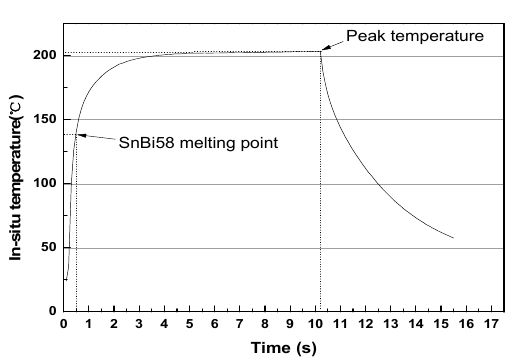
Figure 8. A schematic of TC bonding.